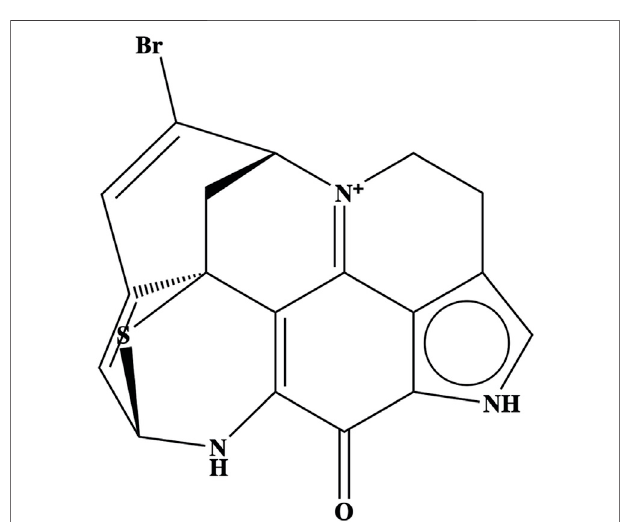
FIGURE 5 | Structure of